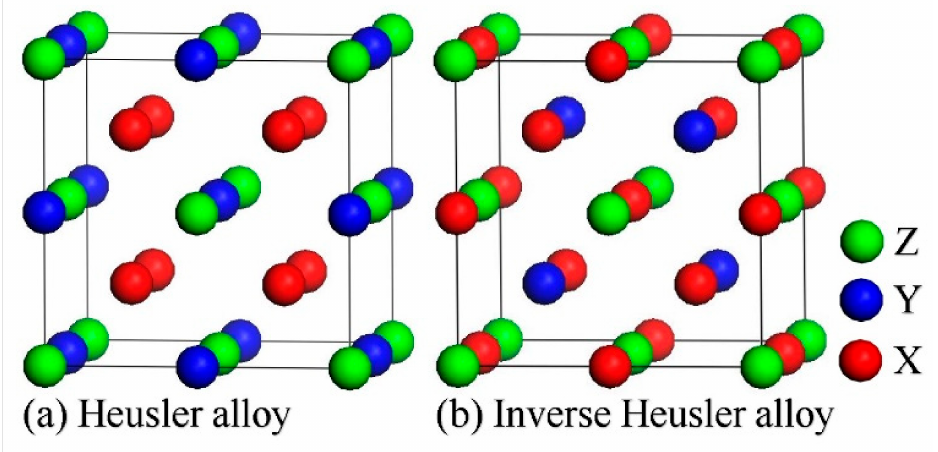
Figure 1. L2 1 crystal structure for the ( a ) regular, and ( b ) inverse, ( XA ) Heusler alloys. These are L2 1 crystal structures where the atomic arrangement along the diagonal direction